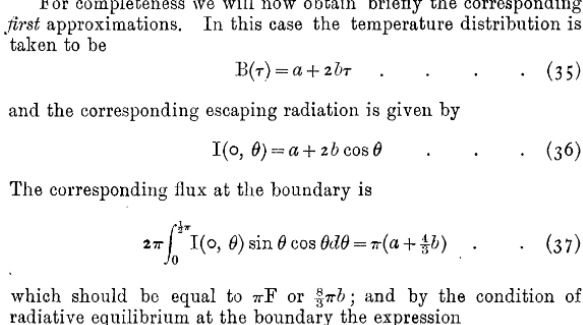
Figure 1. In this excerpt of Milne’s (1921) article, B ( τ ) should also read as the source function and Eqs. (36) and (37) are just the Eddington–Barbier relationships respectively on the specific in- tensity and on the flux, published more than twenty years before Barbier